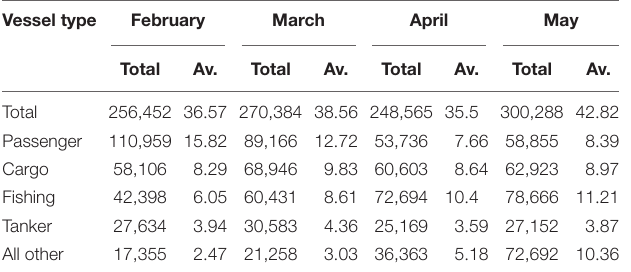
night and from 0.8 to 9.8 dB during the day. The shipping noise indicators (63–125 Hz), had a reduction of 8.9 ± 0.9 (MAD) dB during the day and 1.9 ± 0.1 (MAD) dB during the night ( Table 3 ). Before lockdown, the median noise levels were 3.5 ± 2.19 (MAD) dB higher during the day vs. the night. After lockdown, the noise levels were 0.9 ± 0.52 (MAD) dB higher during the day vs. the night ( Table 3